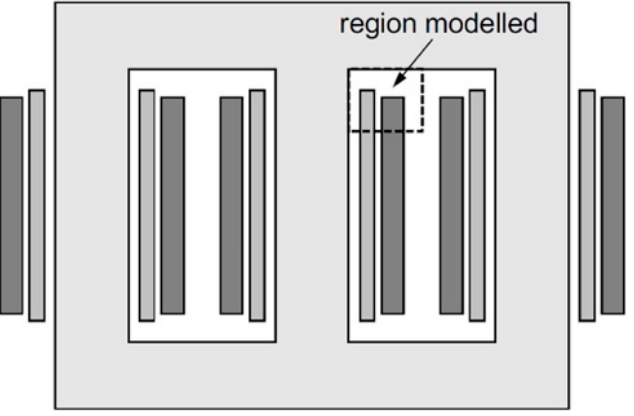
Figure 5. Three-phase transformer